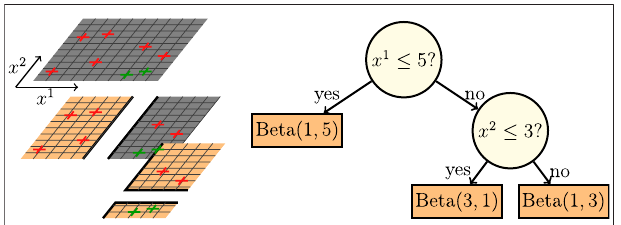
FIGURE 1 | Example of a Bayesian Decision Tree for a 2-categories example in R 2 . On the left: the data set is displayed three times. The fi rst layer corresponds to the data set before any split. The second layer displays the two sets resulting from splitting along dimension 1. The third layer is an additional split of the right subset along dimension 2. The fi nal leaves are displayed in orange. On the right: equivalent tree with posterior distributions for probability of being red assuming a Beta ( 1 , 1 ) prior distribution. The marginal likelihood of the tree is p ( D | T ) (cid:1) B ( 1 , 5 ) B ( 3 , 1 ) B ( 1 , 3 ) / B ( 1 , 1 ) 3 , where B is the Beta